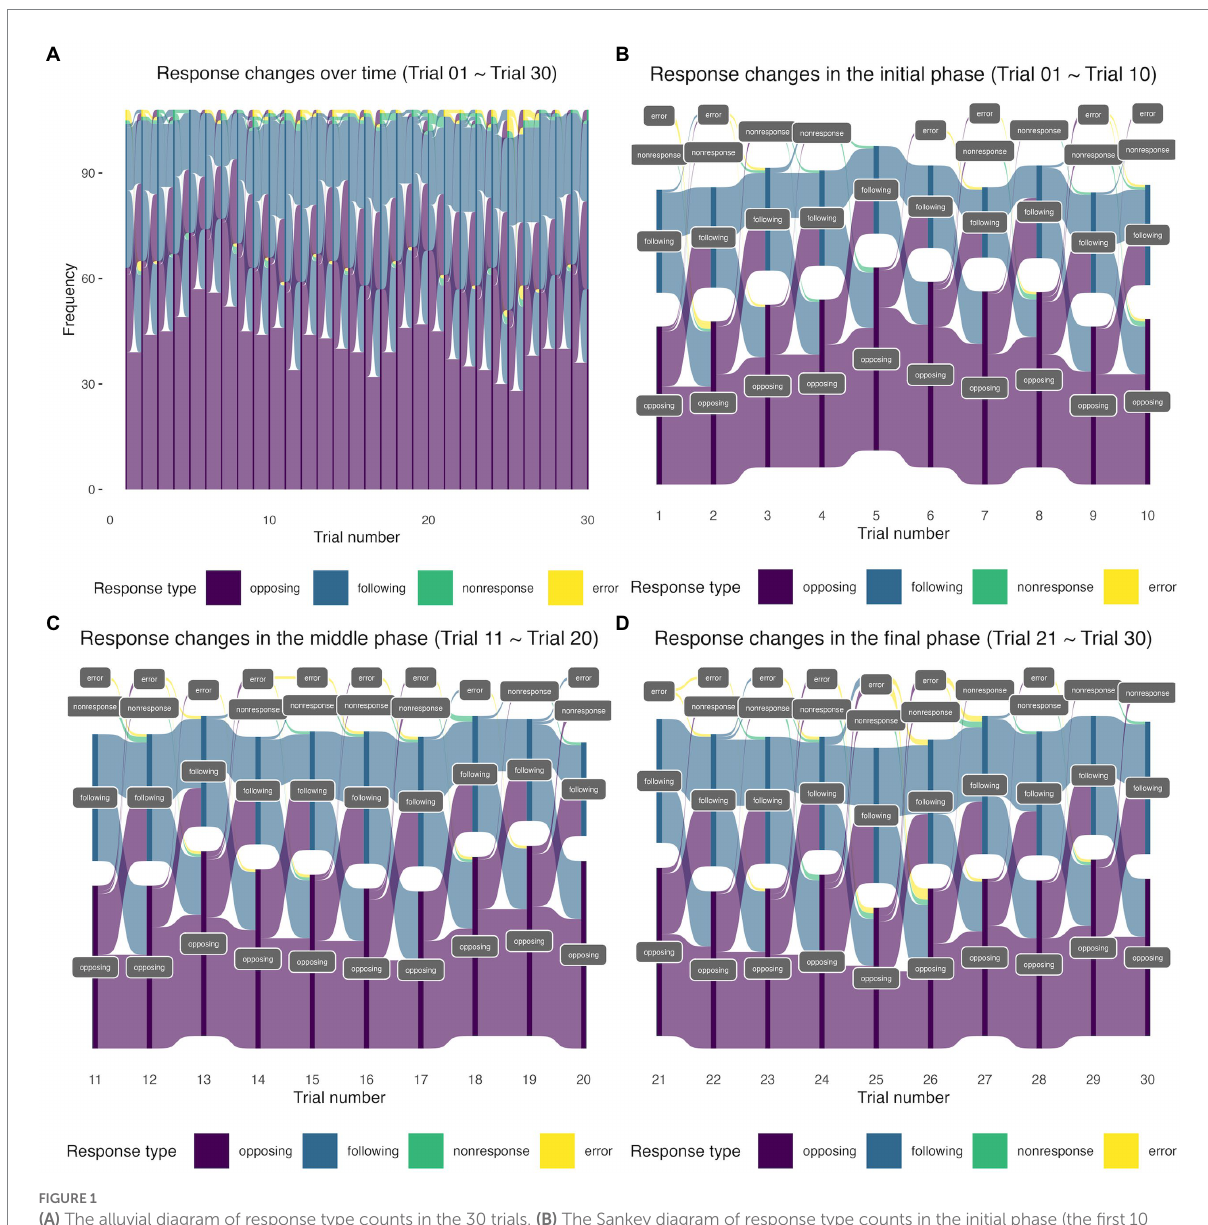
FIGURE 1 (A) The alluvial diagram of response type counts in the 30 trials. (B) The Sankey diagram of response type counts in the initial phase (the first 10 trials). (C) The Sankey diagram of response type counts in the middle phase (the middle 10 trials). (D) The Sankey diagram of response type counts in the final phase (the last 10 trials). The height of the nodes (dark purple, dark blue, dark green, and dark yellow) shows the frequency (counts) of each response type (coded in different colors) in each trial. The curves between the trials coded in light purple, light blue, light green, and light yellow represent the transitions from one response type to another. The widths of the curves are proportional to the transition rate. Sankey plots are similar to alluvial plots but differ in the presence of spaces between nodes at each stage (i.e., trial, in our case). The presence of spaces between nodes at one trial in the Sankey plots enhances the visualization of the transition